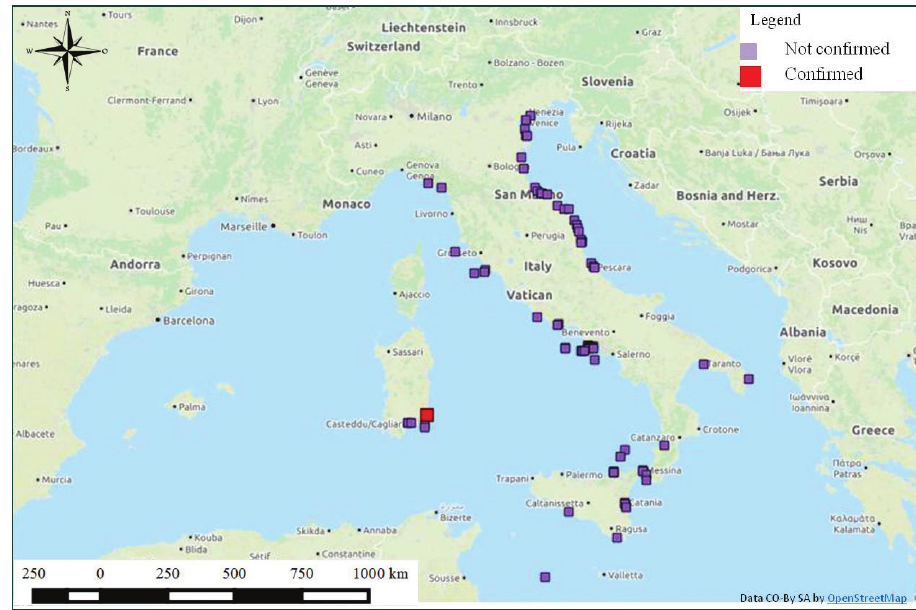
Figure 8. Italian distribution map of Ambrosia maritima based only on verified sites and herbarium